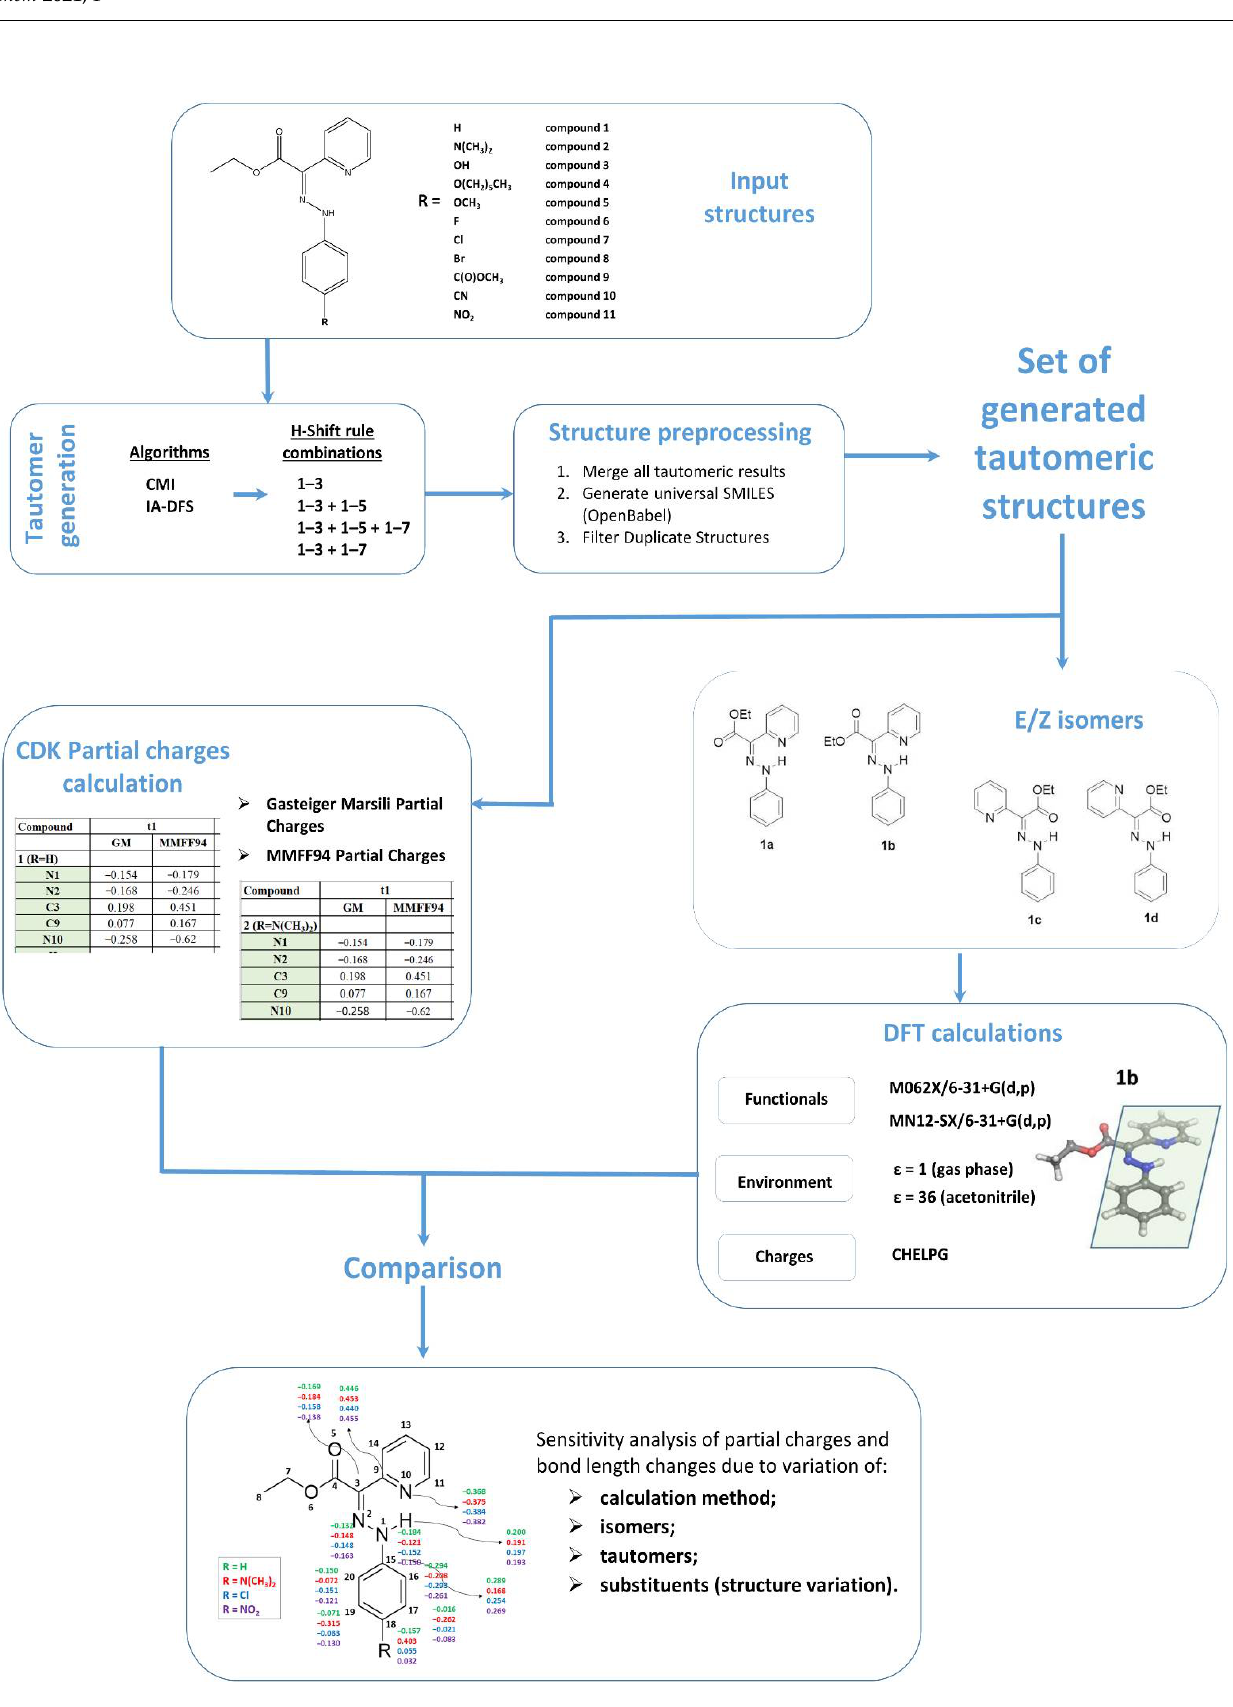
Figure 1. Workflow of the chemoinformatics and DFT study: input, structure processing, tautomer generation, partial charge calculations, DFT calculations and parameter comparison (sensitivity analysis).